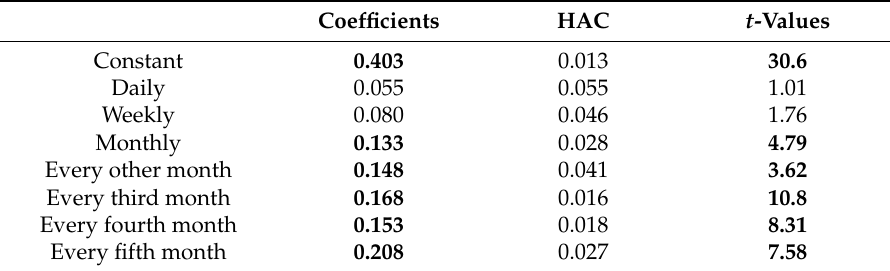
Table 10. OLS Estimates from Equation (3) (bold denotes